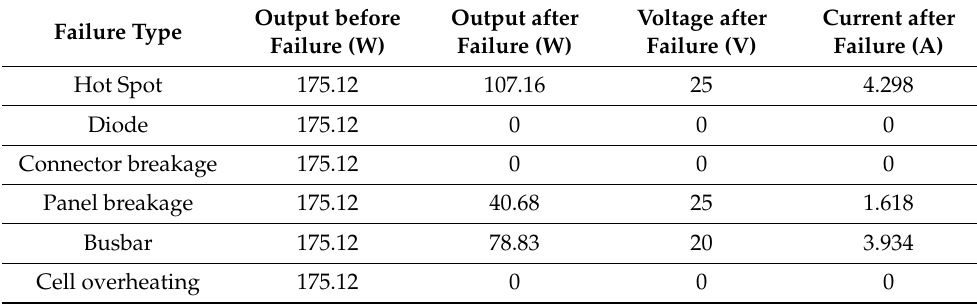
Table 6. Power output of the 220 W PV panel after different failure types.